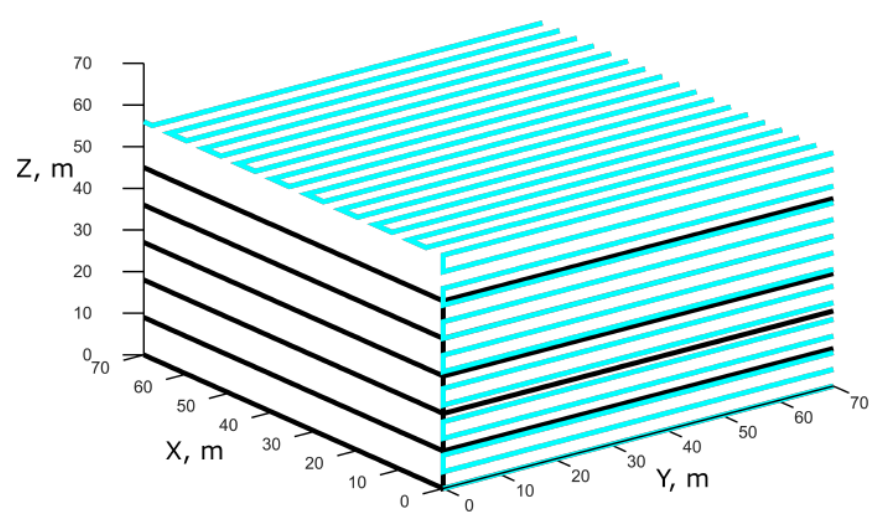
Figure 6. Zoomed in trajectory around a building 300 × 200 × 50.